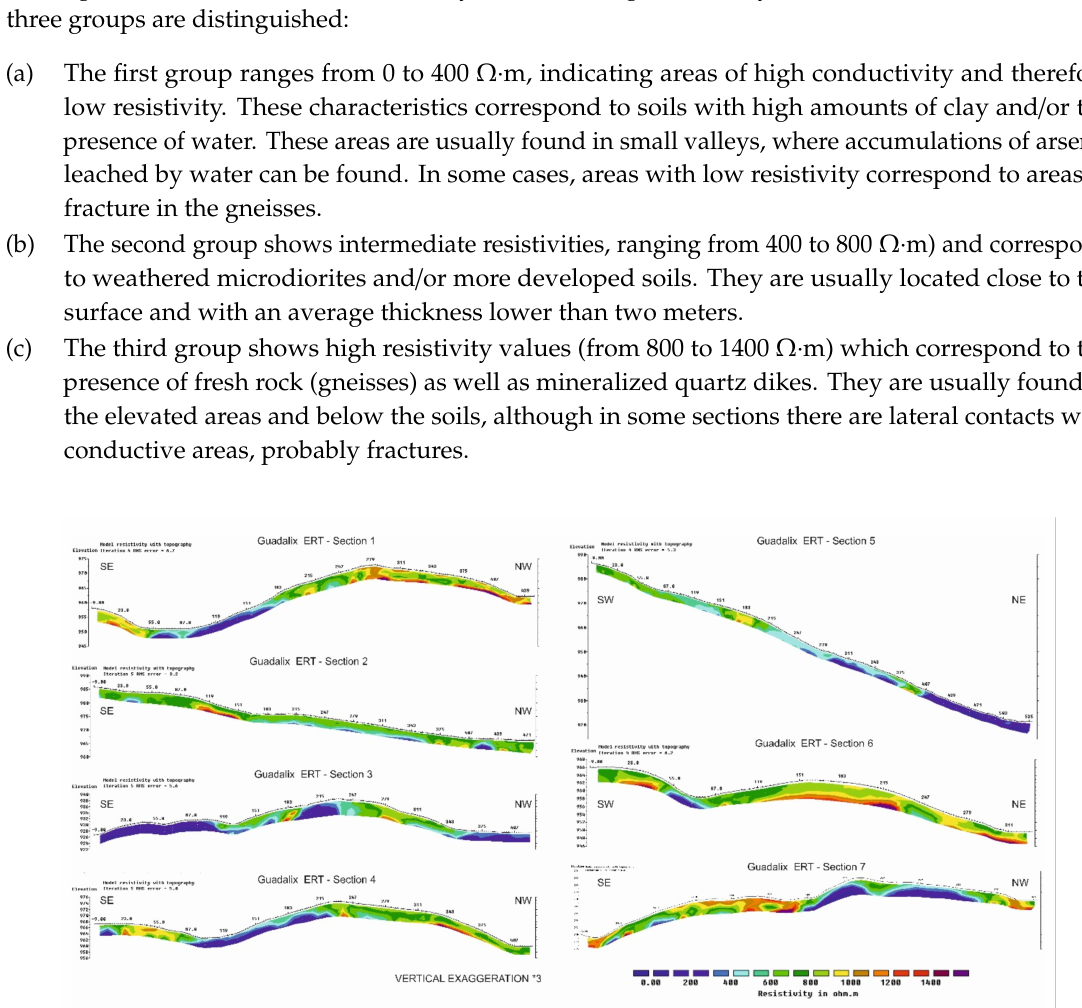
Figure 9. Tomography resistivity inversion of the 7 sections represented in Figure 8. All sections have the same color scale and an × 3 vertical